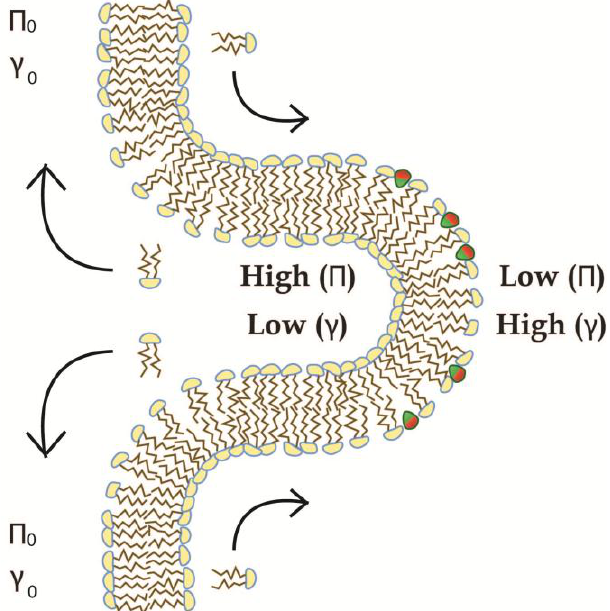
Figure 11. Alterations of properties in local curvatures by the Marangoni Flow of lipids. When local curvatures are generated on coupled membranes, the elastic properties of the local curvature, represented here by surface tension ( 𝛾 ) and lateral pressure ( Π ) are changed relative to the elastic properties of the membrane reservoir ( 𝛾 0 and Π 0 ) . This will generate a flow of lipid away from the area of high lateral pressure into the area of higher surface tension (arrows).